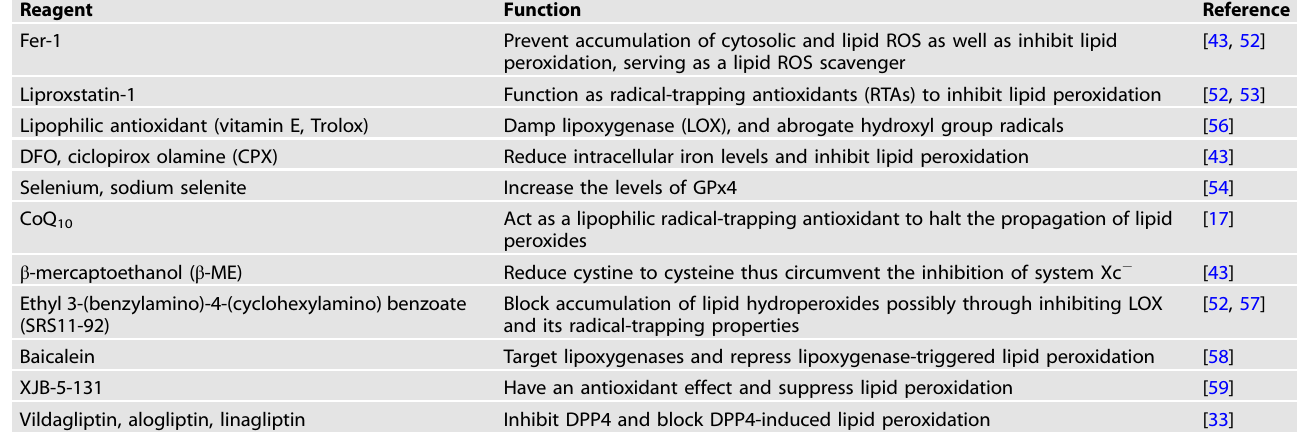
Table 2. Major inhibitors that modulate